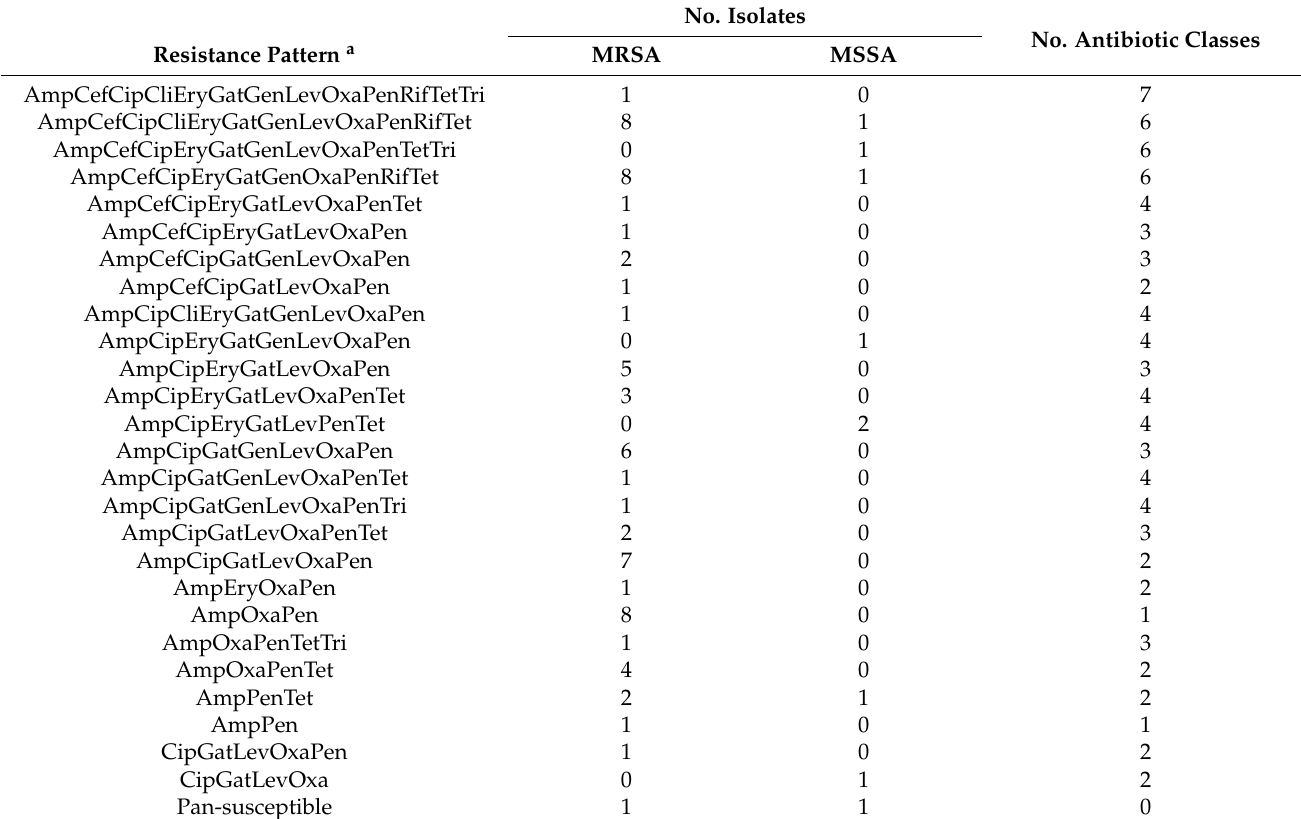
Figure 1. Percent resistance of Staphylococcus aureus ( n = 76) to tested antimicrobials using broth microdilution. No resistance to daptomycin, linezolid, high-level streptomycin, Quinupristin/Dalfopristin, tetracycline, or vancomycin was detected. Table 1. Multidrug resistance patterns among clinical Staphylococcus aureus .